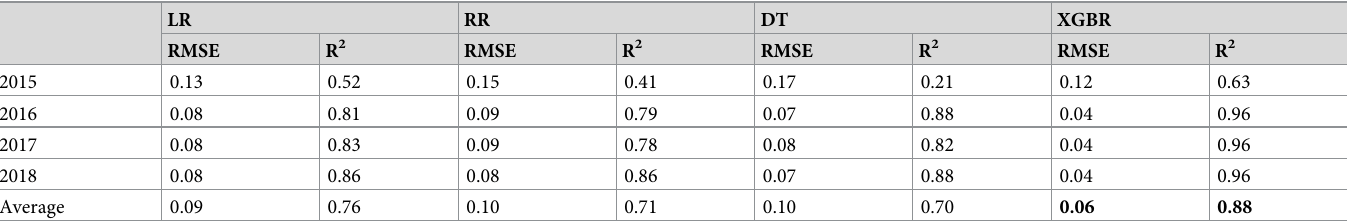
Table 4. Performance for the four different applied models in provincial analysis: Linear Regression (LR), Ridge Regression (RR), Decision Tree Regressor (DT), Extreme Gradient Boosting Regressor (XGBR). The last row shows the metric’s average value for the four years. LR RR DT XGBR RMSE R 2